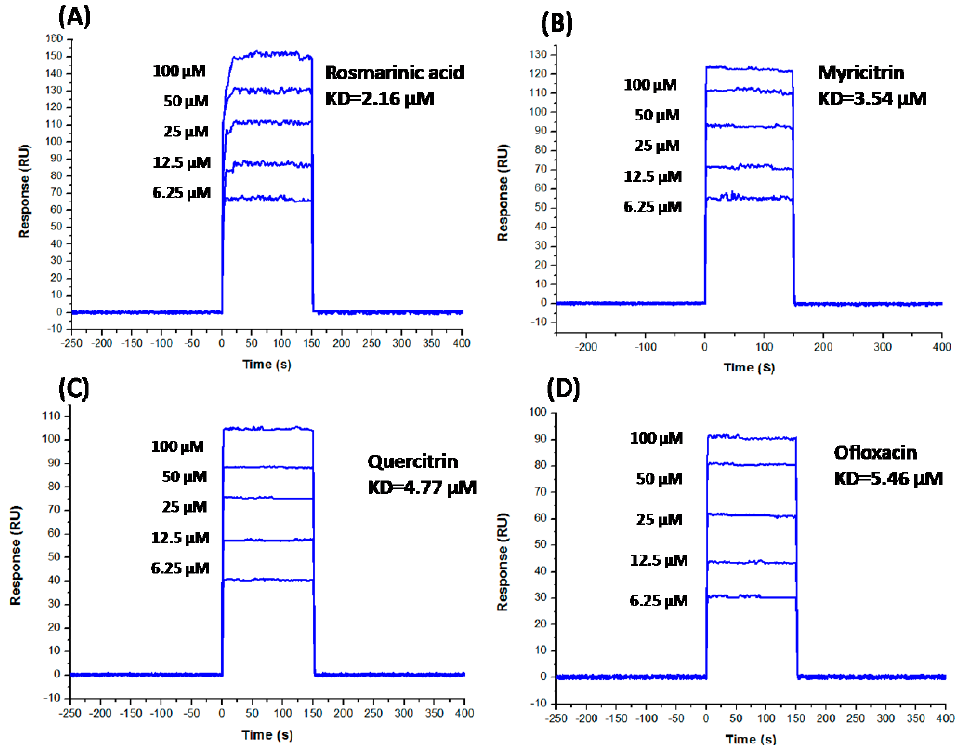
Figure 6. The direct binding affinity of selected compounds with vaccinia virus TOP1 was identified by SPR. ( A ) TOP1+Rosmarinic acid; ( B ) TOP1+Myricitrin; ( C ) TOP1+Quercitrin; ( D ) TOP1+Ofloxacin.